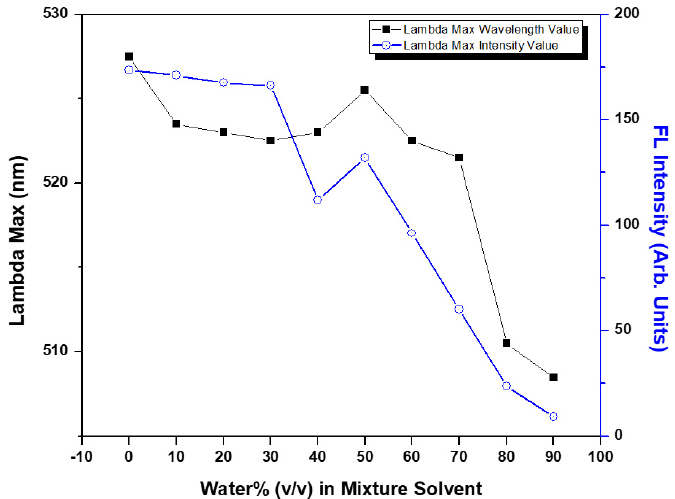
Figure 10. Fluorescence intensity and emission peak of polymer 1 as a function of water content in CH 3 OH (1 μ M repeating units, λ ex at 343